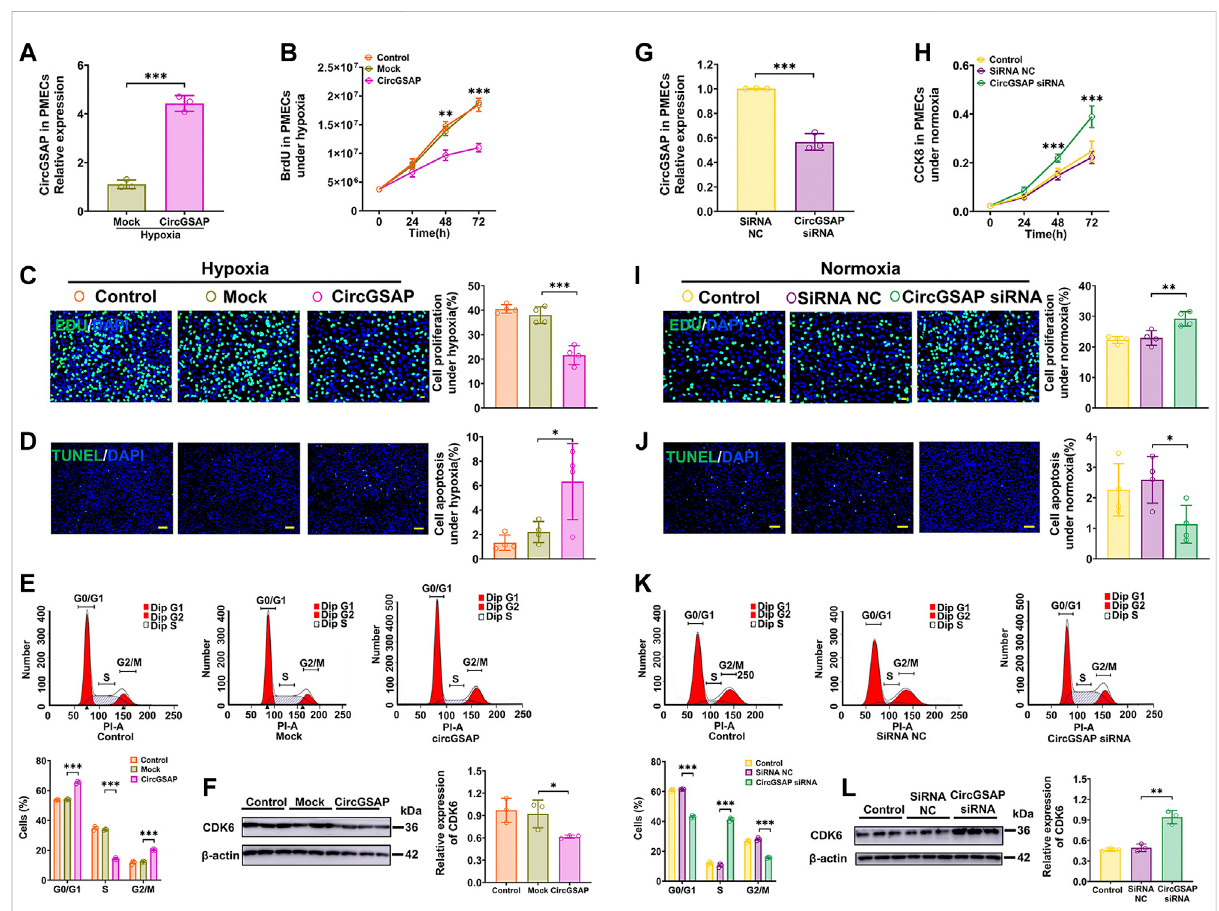
FIGURE 2 Effects of circGSAP on the proliferation, apoptosis and cell cycle of PMECs. (A) Expression levels of circGSAP in PMECs transfection with circGSAP plasmid ( n = 3). (B – E) Cell proliferation analysis, EDU analysis, cell apoptosis analysis ( n = 4) and cell cycle analysis ( n = 3) of PMECs with overexpressing circGSAP underhypoxia. (F) The expressionofCDK6 in PMECs transfected with circGSAP was analyzed byWB ( n =3). (G) Expression levelsofcircGSAPinPMECsaftertransductionwithcircGSAPsiRNA( n =3). (H – K) Cellproliferationanalysis,EDUanalysis,cellapoptosisanalysis ( n = 4) and cell cycle analysis ( n = 3) of PMECs with silencing circGSAP under normoxia. (L) The expression of CDK6 in PMECs transfected with circGSAP siRNA was analyzed by WB ( n = 3). All data are presented as the mean ± SEM. (scale bar, 100 μ m). * p < 0.05; ** p < 0.01; *** p <